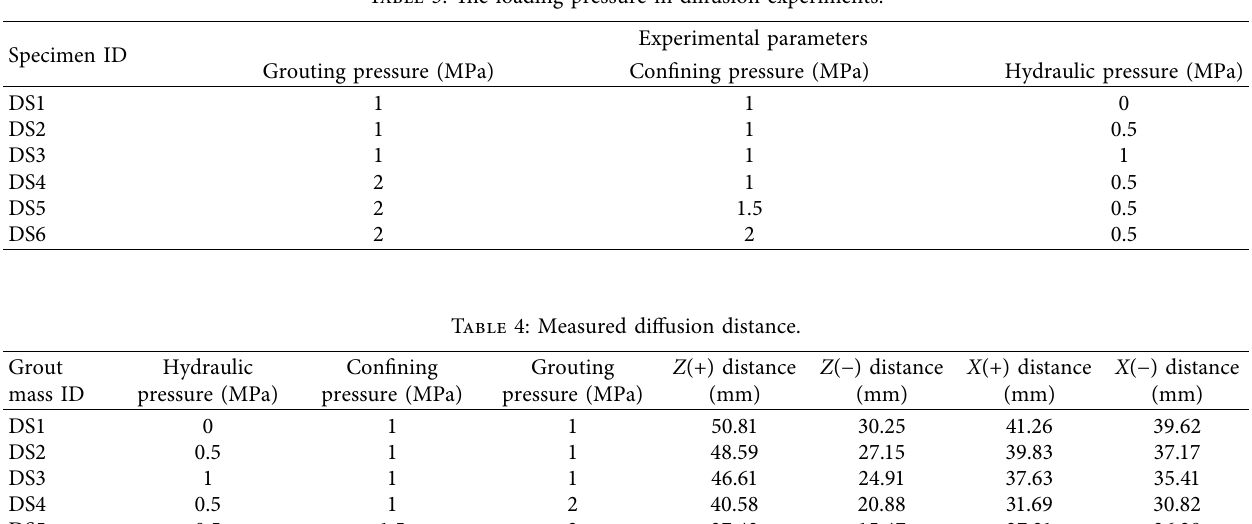
Table 3: The loading pressure in diffusion experiments.